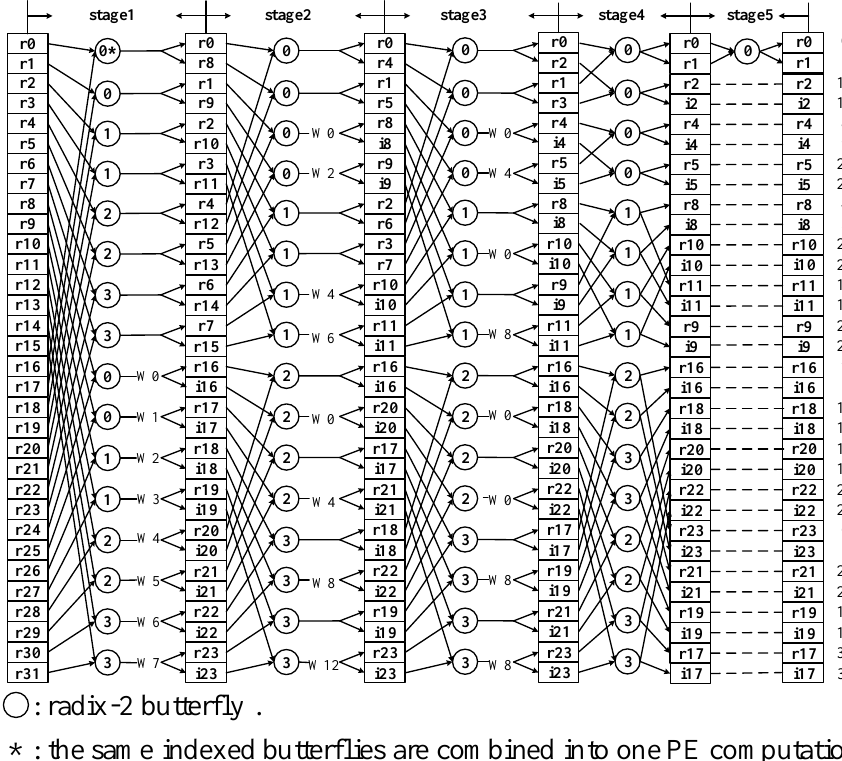
Figure 1. Proposed signal flow graph of a 32-point real-valued FFT (RFFT).